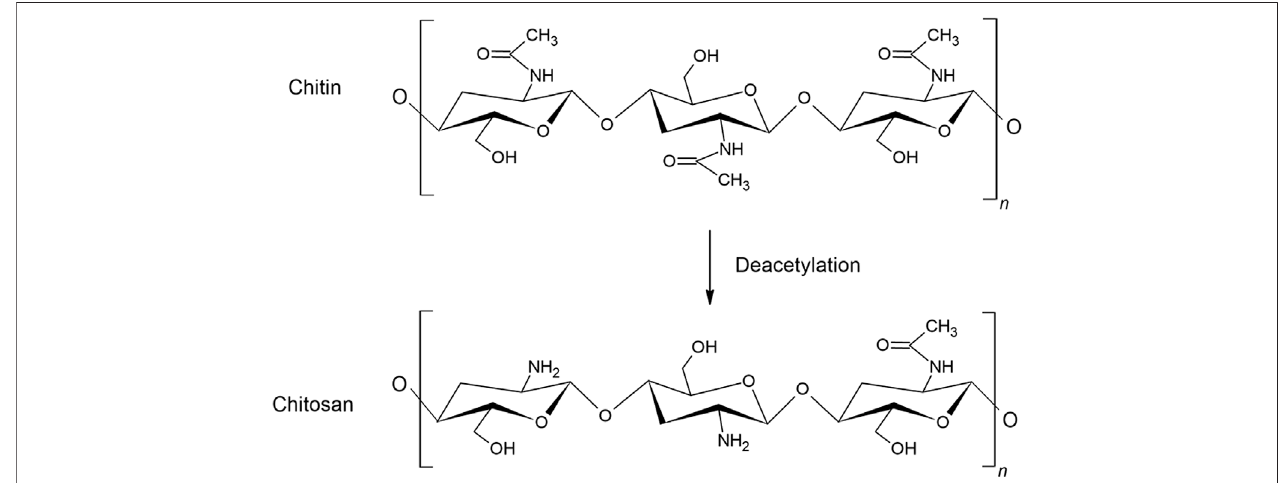
FIGURE 1 | The conversion of chitin to chitosan by N-deacetylation.